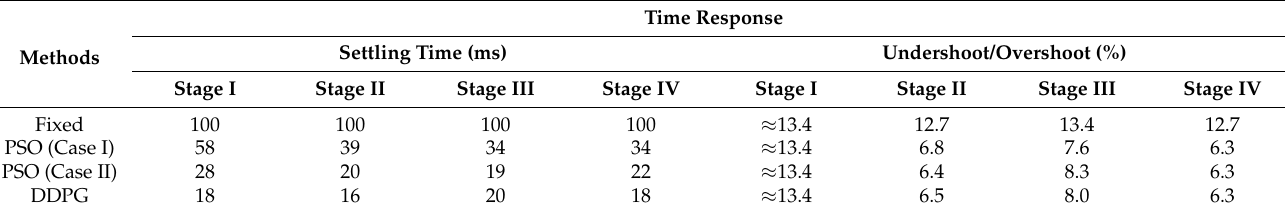
Figure 11. Comparison of the four tuning methods. Table 6. Values of settling time, undershoot, and overshoot of each